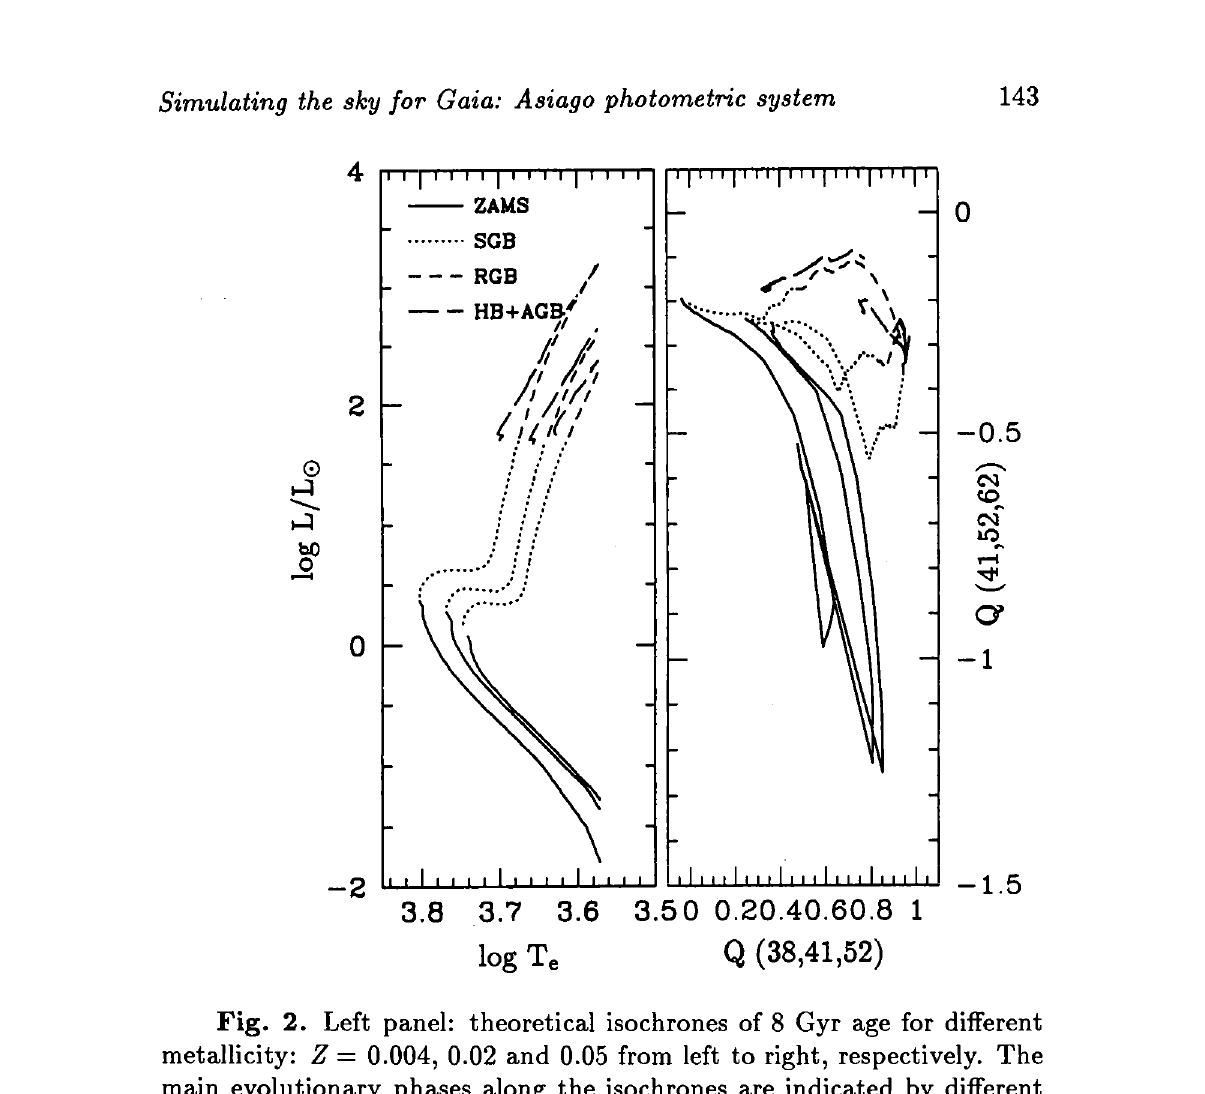
Fig. 2. Left panel: theoretical isochrones of 8 Gyr age for different metallicity: Ζ = 0.004, 0.02 and 0.05 from left to right, respectively. The main evolutionary phases along the isochrones are indicated by different lines. Right panel: the same isochrones in the reddening-free parameter diagram for the passbands g3865, g4125, g5190 and g6235.